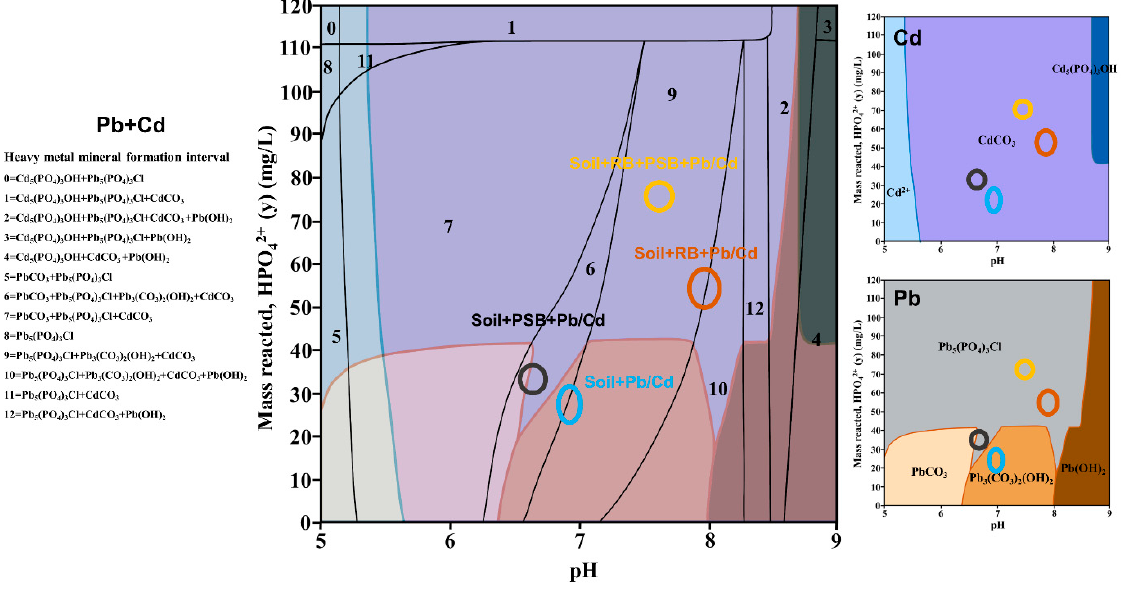
Figure 5. Final minerals (Pb + Cd) formed by different treatments in the GWB model (RB—rice husk biochar, PSB— Enterobacter sp.).